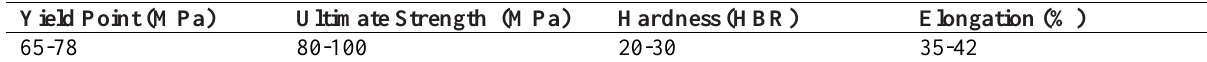
Mechanical properties of Al 1050 alloy..“ Yield Point (MPa)